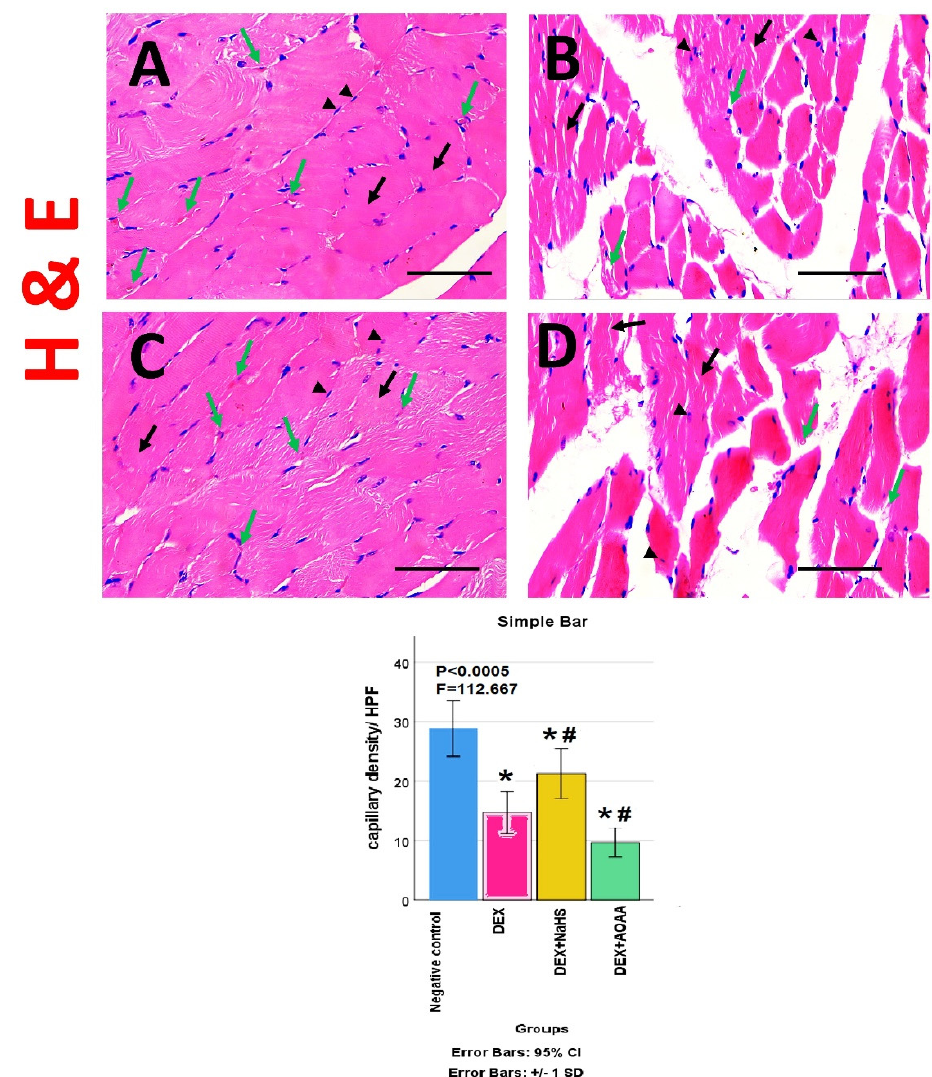
Figure 3. ( A – D ) Photomicrographs of transverse sections for the soleus muscle of different groups: ( A ) Group I (negative control) showed normal appearance of skeletal muscle fibers and closely- packed bundles with polygonal acidophilic muscle fibers (black arrows) with peripheral oval nuclei (arrow heads) and no atrophic changes with a big number of capillaries (green arrows); ( B ) Group II (Dex) shows loosely-packed muscle bundles, many fibers with fragmented cytoplasm (black ar- rows) and displacement of some nuclei away from the periphery (arrows heads), as well as bundle and fiber atrophy, angling and/or degeneration with a few number of capillaries (green arrows); ( C ) Group III (Dex + NaHS) shows remarkable preservation of the normal structure with closely-packed muscle bundles, muscle fibers with polygonal acidophilic muscle fibers no remarkable atrophic changes (black arrows) with peripheral oval nuclei (arrowheads). with a big number of capillaries (green arrows); ( D ) group IV (Dex + AOAA) showing loss of normal architecture, loosely-packed muscle bundles and fragmented muscle fibers (black arrows) and fiber atrophy, angling, and/or degeneration, with fragmented cytoplasm and displacement of some nuclei away from the periph- ery (arrowheads) with a few number of capillaries (green arrows). Scale bar: 25 um (HE stain × 400). The histogram shows the capillary density/High power field. Dex: Dexamethasone, NaHS: Sodium hydrosulfide and AOAA: Aminooxyacetic acid. HPF: High power field. p : significance (<0.05). *: significance as compared to the control ( C ) group. #: significance as compared to (Dex) group.